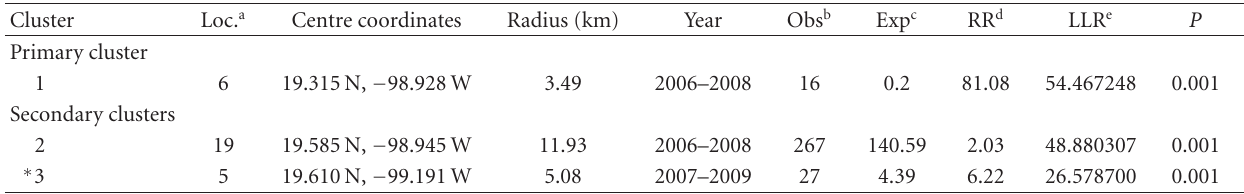
Table 2: A cluster with high rates of tuberculosis in the State of Mexico was detected with a spatial-temporal analysis and a search window maximum length of ≤ 50% and ≤ 25% risk population, adjusted for age-gender-margination. Cluster Loc. a Centre coordinates Radius (km) Year Obs b Exp c RR d LLR e P